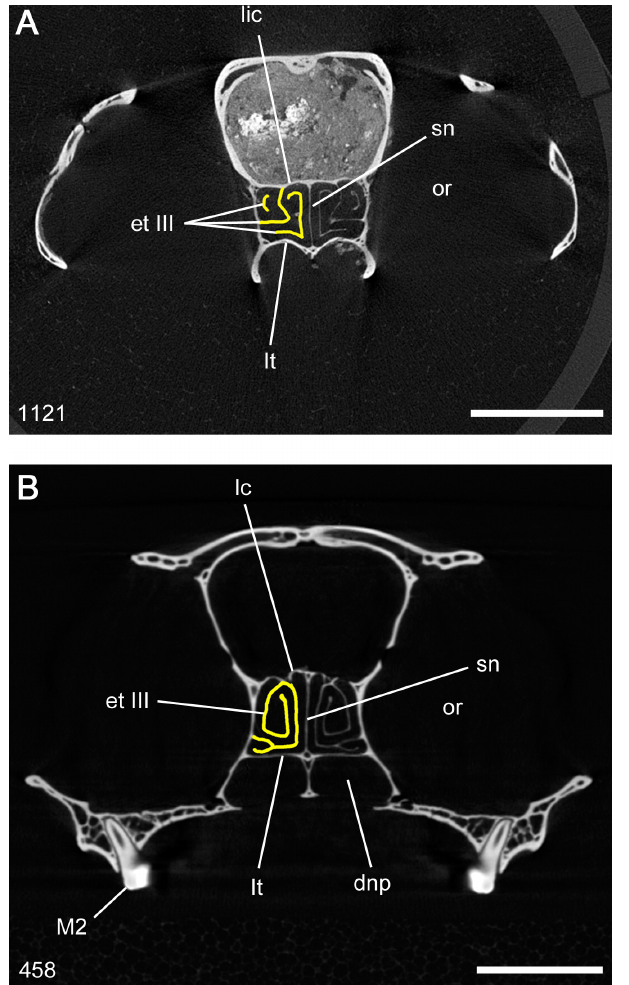
Figure 14. µCT cross-section images of the pars posterior of the adult rostrum and orbit from anterior to posterior of (a) Ptilocer- cus lowii (ZMB 3992) and (b) Tupaia sp. (collection W. Maier). Numbers in figures refer to number of original µCT slices. Abbre- viations: dnp, ductus nasopharyngeus; et III, ethmoturbinal III; lc, lamina cribrosa; lic, lamina infracribrosa; lt, lamina terminalis; M2, upper molar 2; or, orbit; sn, septum nasi. Scale bars equal